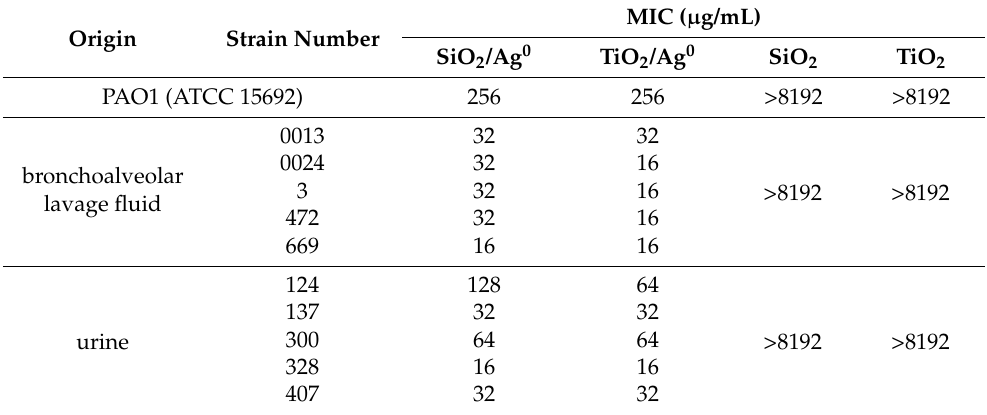
Table 3. Minimal inhibitory concentrations (MICs) of SiO 2 /Ag 0 , TiO 2 /Ag 0 , SiO 2 , TiO 2 against P. aeruginosa